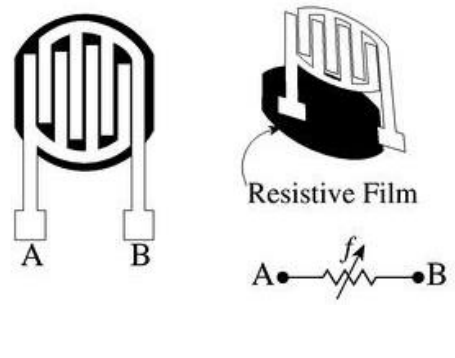
Figure 11. Resistive pressure sensor construction